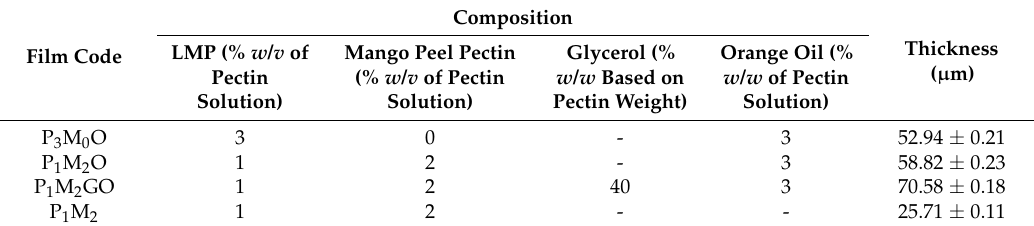
Figure 1. Scanning electron microscopy (SEM) of film’s matrix of P 3 M 0 O ( a ), P 1 M 2 O ( b ), P 1 M 2 GO ( c ), Figure 1 . Scanning electron microscopy (SEM) of film ’ s matrix of P 3 M 0 O ( a ) , P 1 M 2 O ( b ) , P 1 M 2 GO ( c ) , and and P 1 M 2 ( d ) films. P 1 M 2 ( d ) films . Table 2. Film composition and thickness. LMP—low methoxy pectin. Table 2 . Film composition and thickness . LMP — low methoxy pectin .